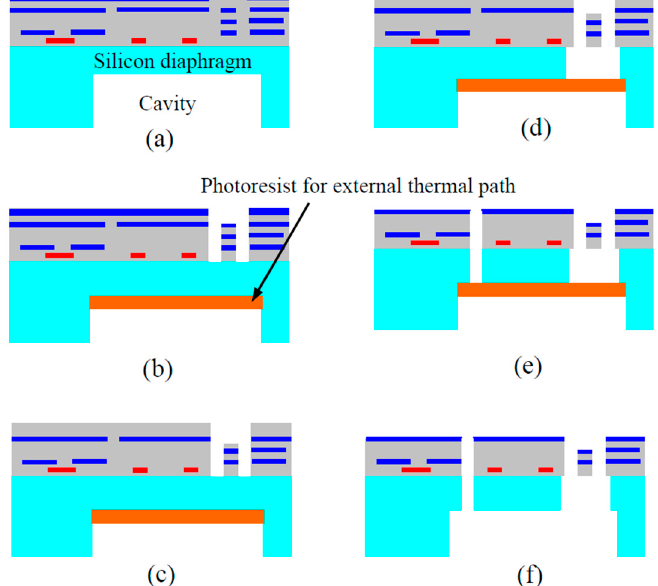
Figure 10. Modified bulk CMOS MEMS process for separate etching of CMOS beams and single crystal silicon (SCS) microstructures [75]. ( a ) Backside silicon DRIE; ( b ) Thermal protection using photoresist (PR); ( c ) Front-side SiO 2 etching; ( d ) Front-side silicon DRIE for beams; ( e ) Front-side silicon DRIE for comb drives; ( f ) Removal of thermal protection PR layer.